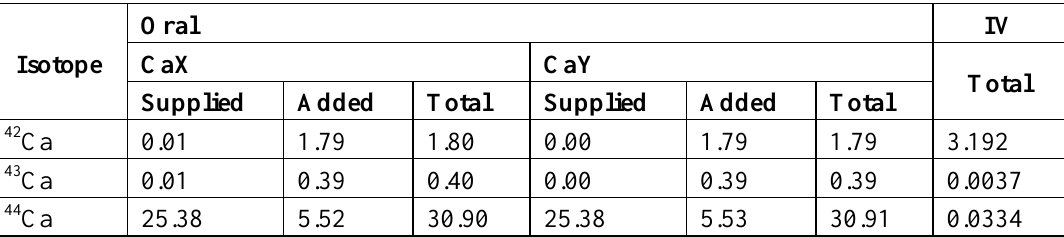
Table 3. Amount of isotope Ca (mg) per subject in 1